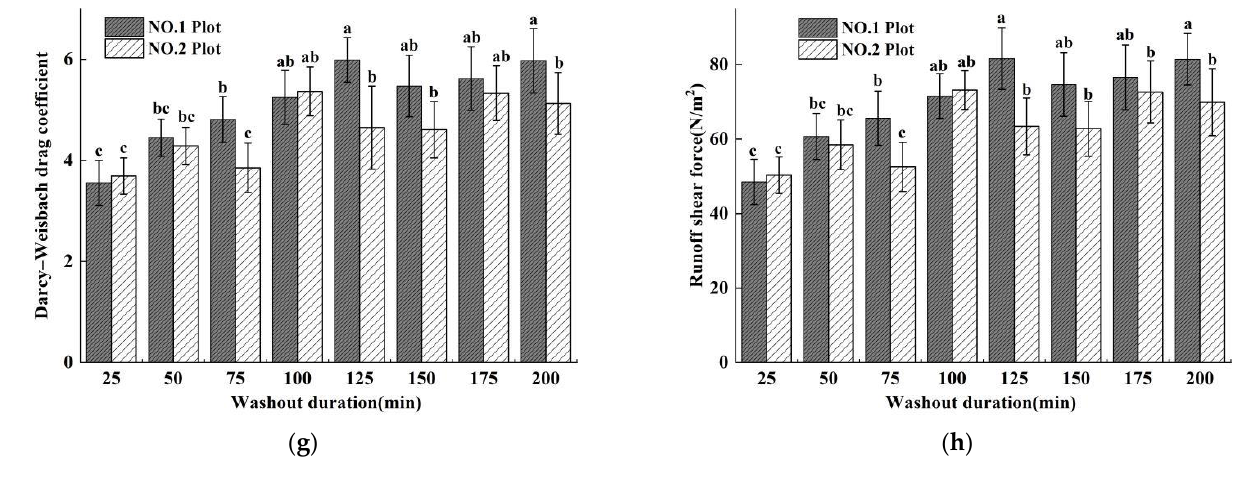
Figure 7. Average velocity ( V ) ( a ), Froude number ( Fr ) ( b ), Unit stream power ( P ) ( c ), Cross-section energy( ε ) ( d ), Hydraulic radius ( R ) ( e ), Reynolds number ( Re ) ( f ), Darcy-Weisbach drag ( DW-f ) ( g ), and Runoff shear force ( τ ) ( h ) in short-term heavy rainfall (No. 1 plot) and moderate rainfall (No. 2 plot) experiments.